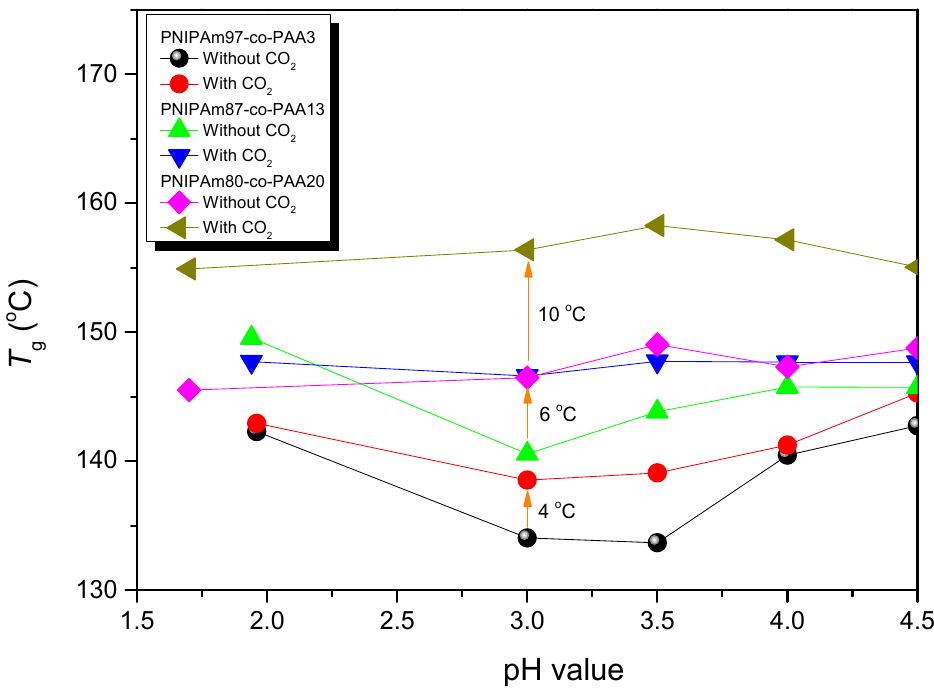
Figure 12. Values of T g of PNIPAAm- co -PAA films cast from aqueous solutions at various values of pH, with or without scCO 2 treatment.